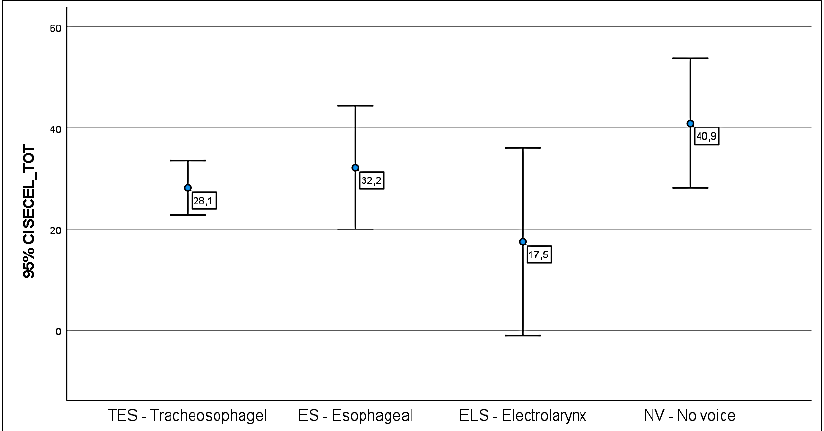
Figure 3. SECEL self-assessment, circle represents the mean, bars represent 95% CIs, labels report the mean. Score legend: cut-off value